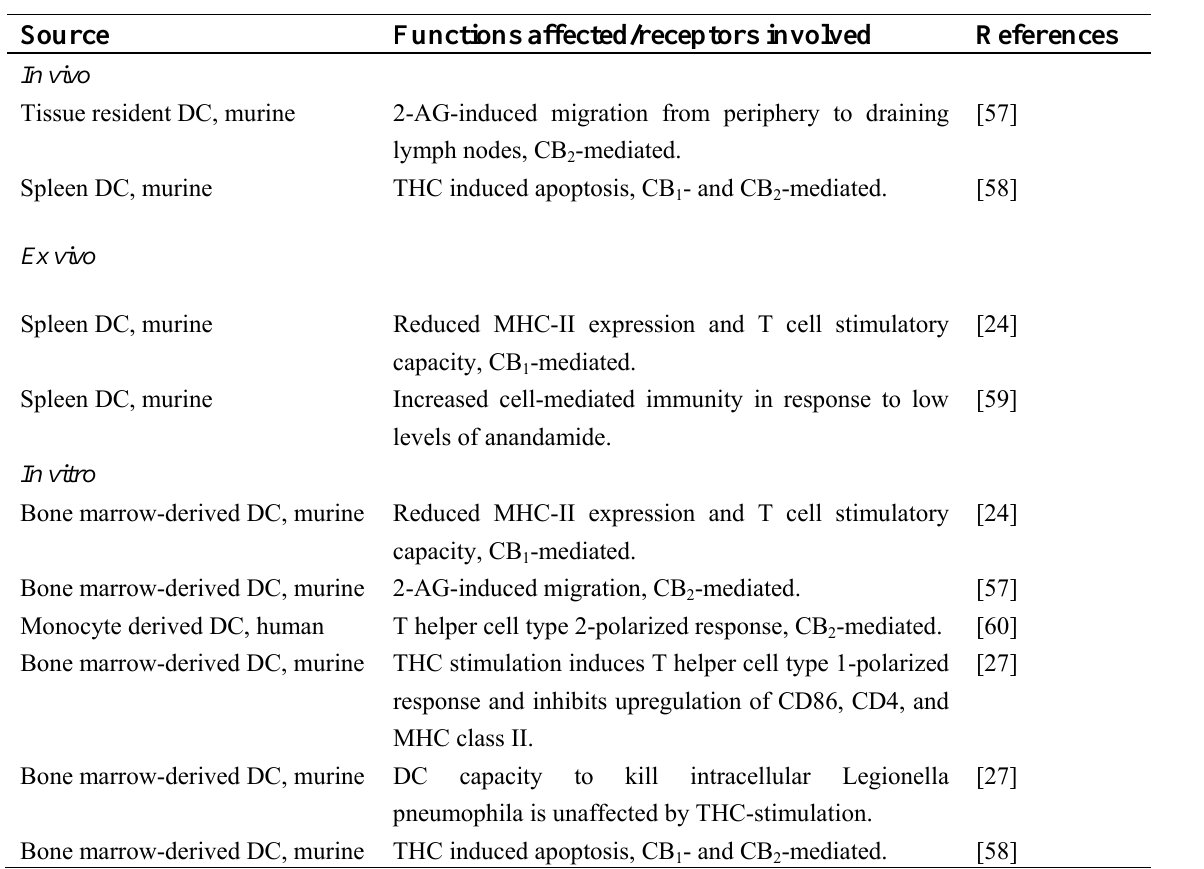
Table 1. Effects of cannabinoids on